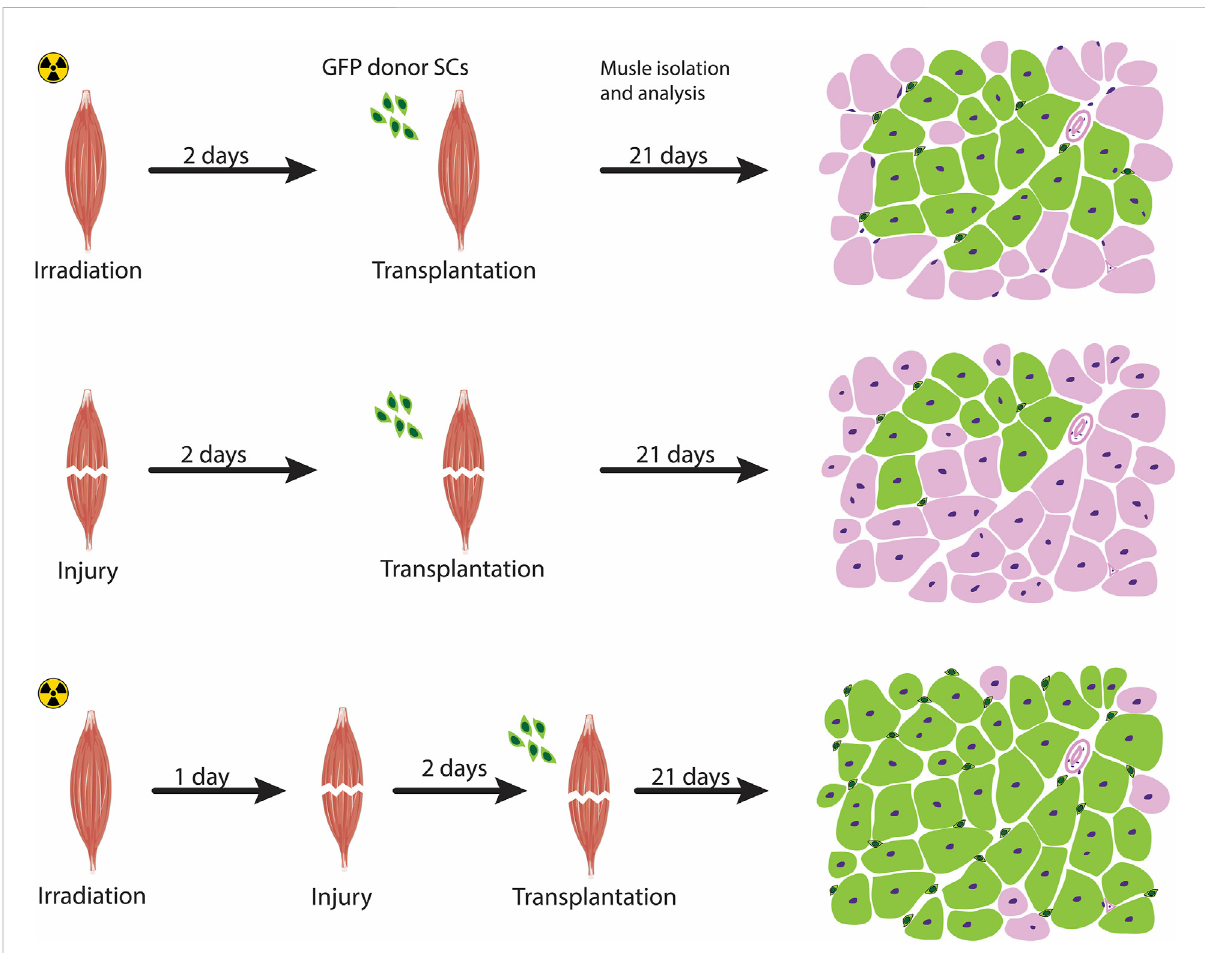
FIGURE 2 Preconditioning the host muscle environment prior to transplantation. Pre-treatment strategies to modulate the host muscle environment includes irradiation (top panel), injury-induced (middle panel), or a combination of irradiation and acute injury (bottom panel). Acute muscle injury combined with irradiation exhibit a high level of engraftment, as schematizedby atransverse section ofa transplanted muscle showing an increased contribution of fi bers by transplanted cells (marked as green fi bers) compared with the other two approaches. The Green cells surrounding the fi bers represent satellite cells donor-derived cells that have undergone